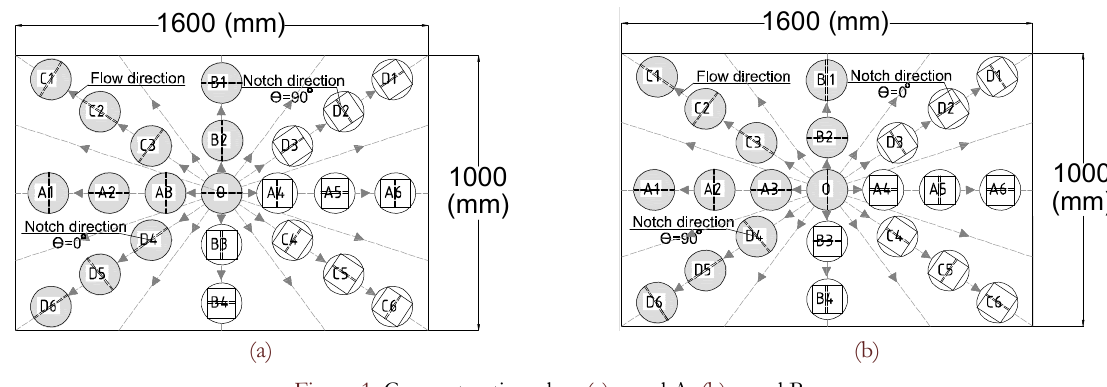
Figure 1: Core extracting plan: (a) panel A, (b) panel